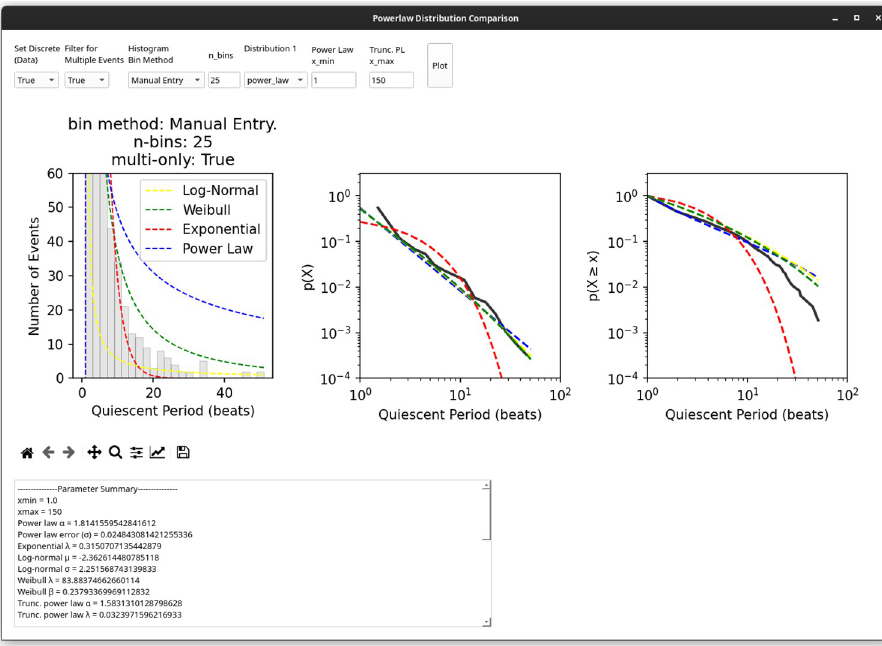
Fig 9. ‘Powerlaw Distribution Comparison’ window. The results of power law analysis, both qualitative (plots) and quantitative (numerical output, text box below plots) are presented in this window of the application. The user can adjust a variety of parameters, as necessary, and execute their analysis by clicking ‘Plot’. The power law plot was adapted from [25].